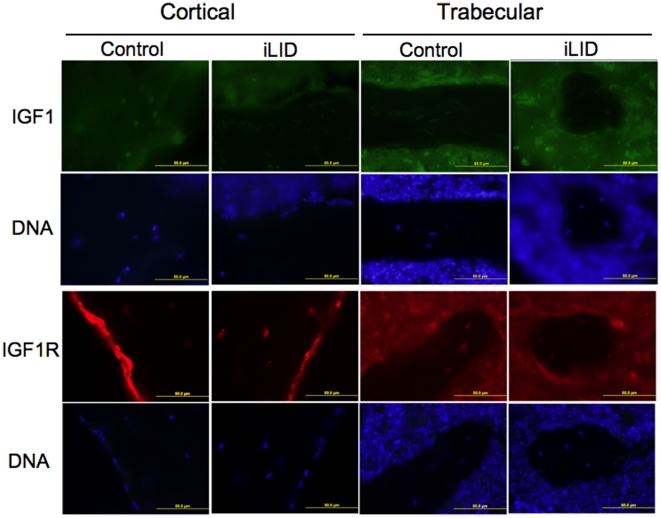
Representative immunofluroescene images of cortical and trabecular bone from 32 week control and iLID mice that were serum IGF-1 depleted at 16 weeks of age.Antibody staining for IGF-1 and the IGF-1R showed no differences when comparing control and iLID mice.